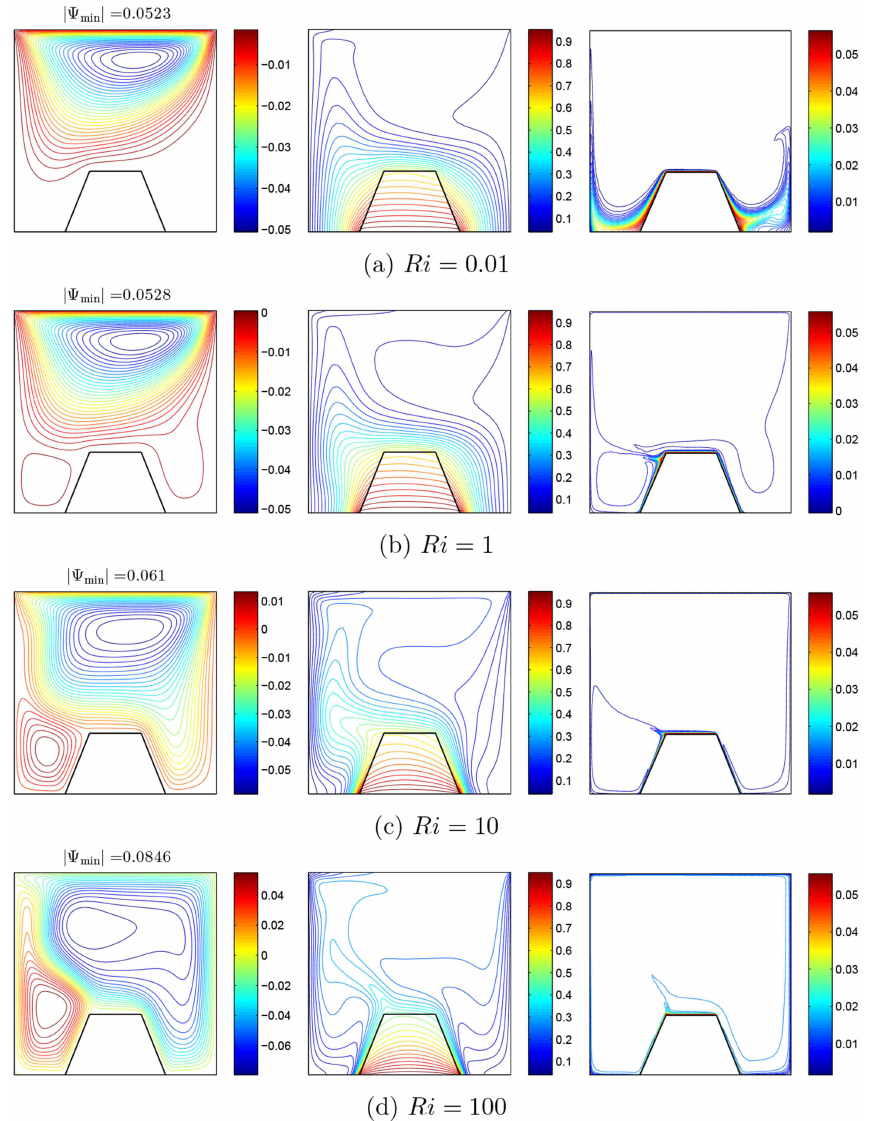
Figure 6. Effects of the Richardson number ( Ri ) on the streamlines (left), isotherms (middle), and nanoparticle distribution (right) for Ha = 20, φ = 0.02, and D = 0.3. Figure 7 examines the effect of the Hartmann number ( Ha ) on the streamlines, isotherms, and nanoparticle distribution for fixed values of Ri = 10, φ = 0.02, and D = 0.3. The flow within the square cavity appears with two streamline circular cells in different directions, one at the upper part and the other at the lower part next to the right wall for the case where Ha = 0. The isotherm